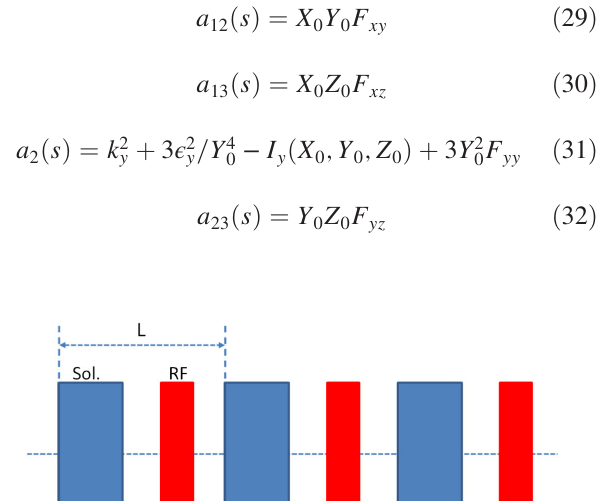
ffiffiffi p 5 for a